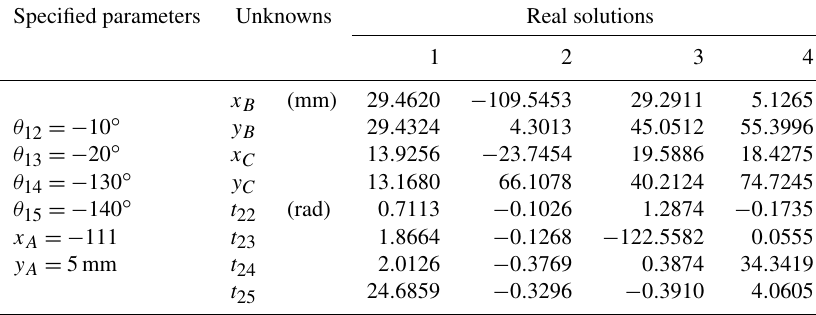
Table A1. Specified parameters and real solutions.